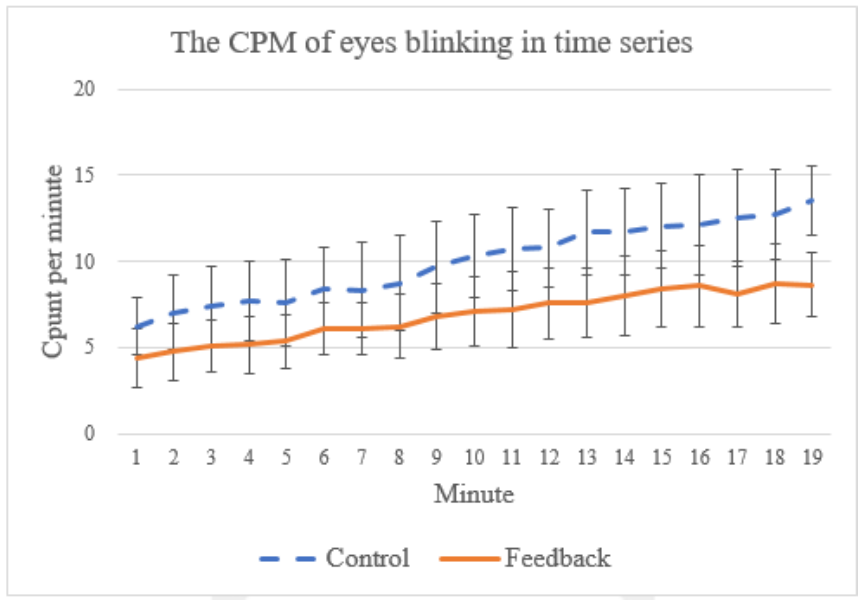
Figure 12. The average theta-to-alpha ratio in each session.